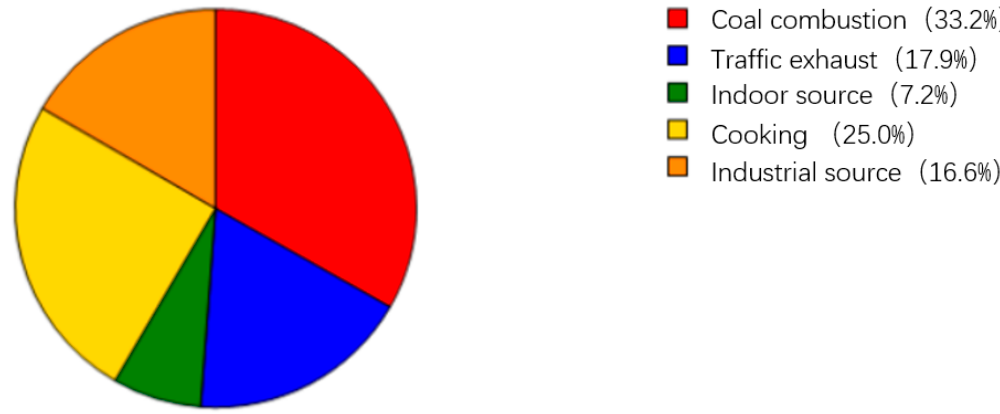
Figure 6. PAH contribution of different sources.